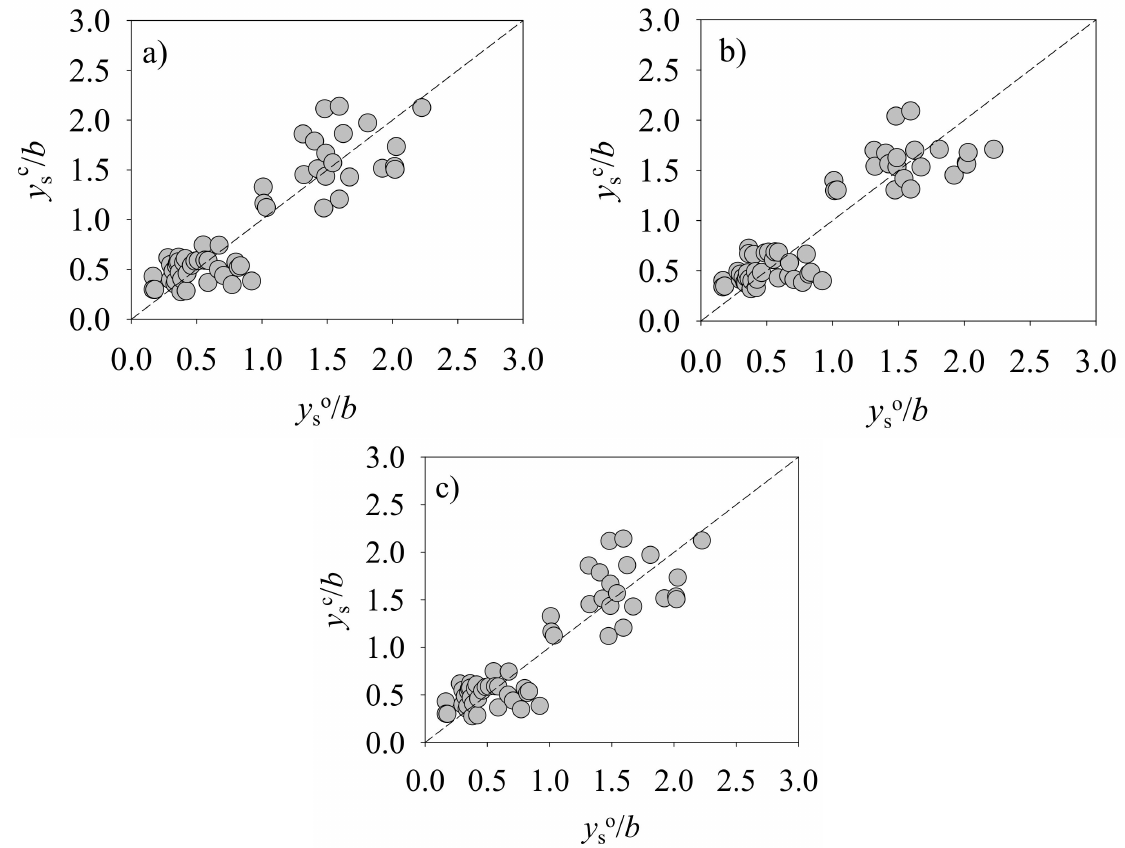
Figure 4. Comparison of the nondimensional observed scour depth, y so / b , and the nondimensional calculated scour depth, y sc / b , for the selected hybrid models after applying the correction factors: ( a ) YJAF-VRAD, ( b ) YJAI-VRAD, and ( c ) YJAF-VARN, (- - - - - - -) perfect agreement